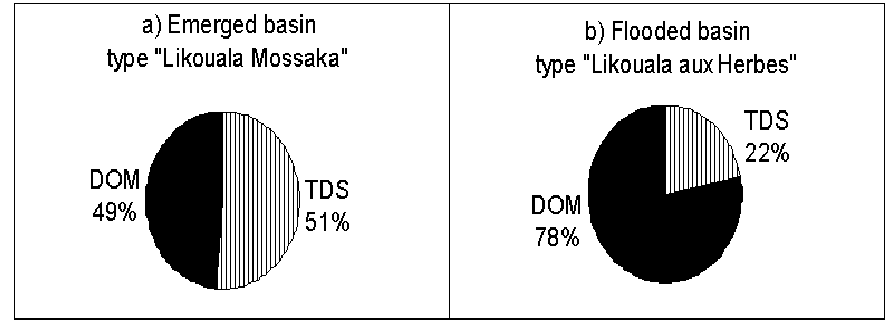
Figure 15. Distribution of dissolved matter (mg L − 1 ) in the emerged ( a ) and flooded ( b ) part of the ‘Cuvette Centrale” [15].